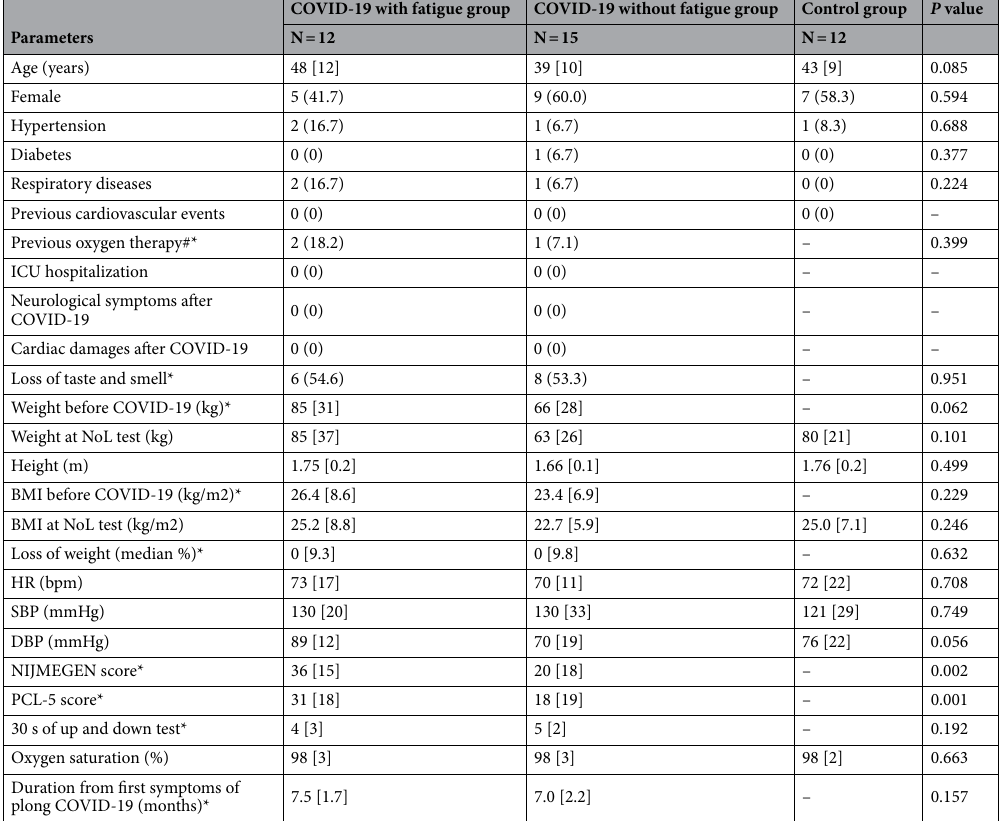
Table 1. Characteristics of the study population. BMI: body mass index. HR: heart rate. SBP: systolic blood pressure. DBP: diastolic blood pressure. ICU: intensive care unit. *Only comparison between “covid-19 participants with fatigue and covid-19 participants without fatigue”. # Oxygen therapy was administrated through low-flow nasal cannula. Categorical values were presented as number and percentage, continuous variables were presented as median and interquartile range